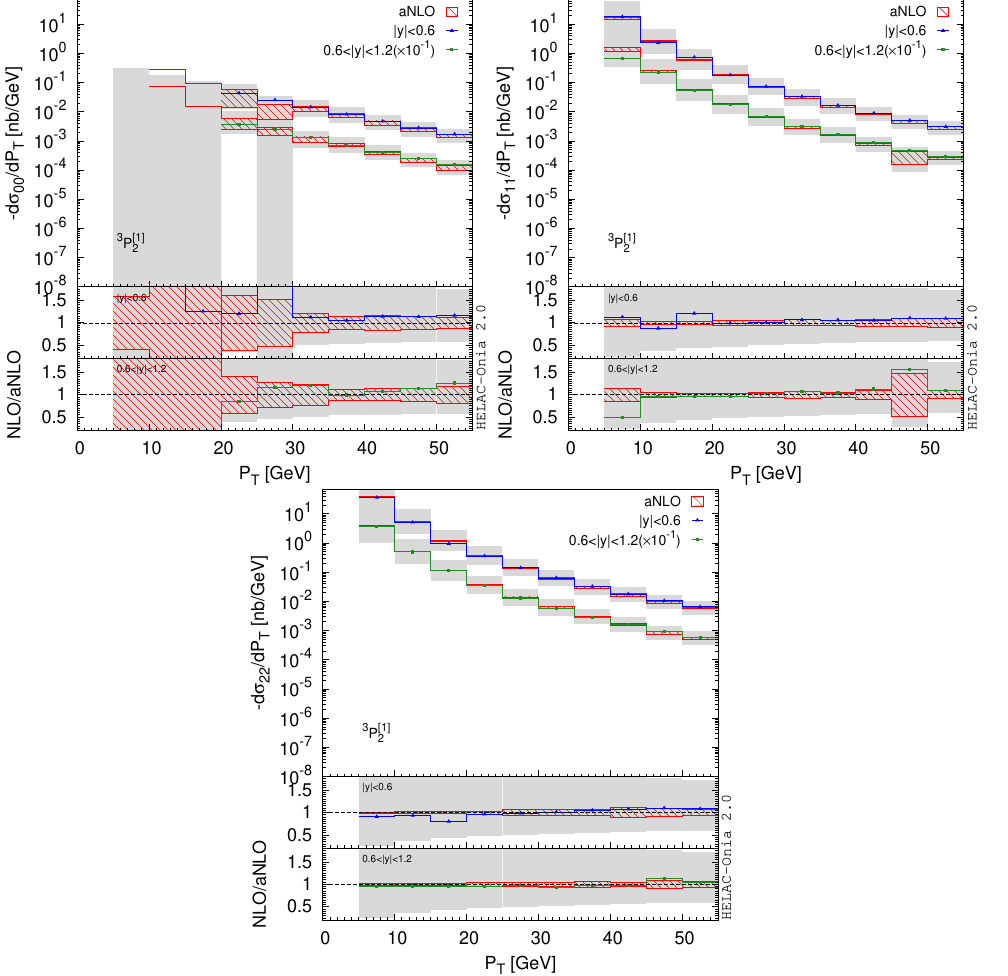
Figure 20 . Comparisons of spin-dependent differential cross sections for the Fock state 3 P [1] between our aNLO calculations and the complete NLO calculations. They are similar to figure